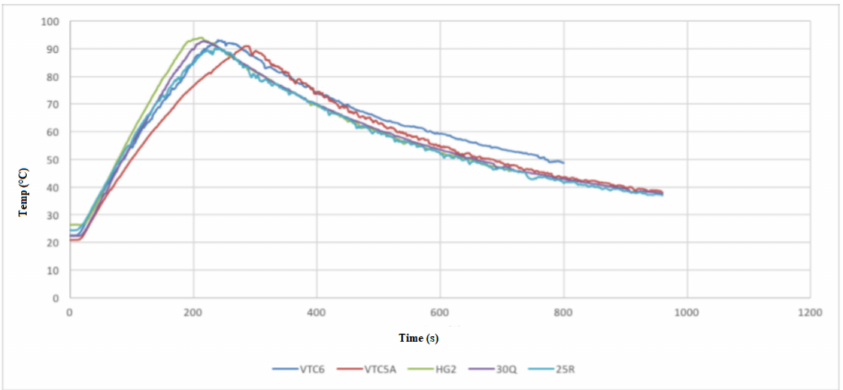
Figure 7. Single cell tests: temperatures from 30 A discharge with no